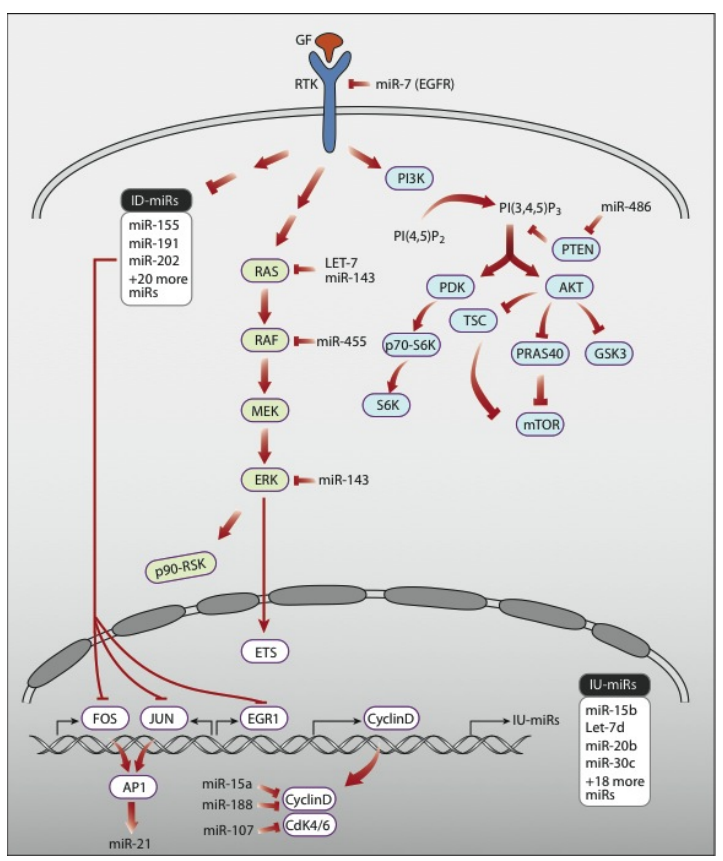
Figure 1. Schematic representation of RTK signaling pathways and representative regulatory microRNAs. Several biochemical signaling pathways are simultaneously activated upon binding of a growth factor (GF) to a receptor tyrosine kinase (RTK). Shown are two major cascades of protein kinases: the RAS-ERK pathway, which culminates in translocation of active ERK molecules to the nucleus, and the PI3K-to-AKT pathway, which requires phosphorylation of the inositol ring of phosphatitylinositol 4,5 bisphosphate at carbon position number 5. Both pathways regulate transcription factors, such as AP1, which comprises dimers of JUN and FOS. Note that many components of the signaling pathways are modulated at the mRNA level by microRNAs. Likewise, several microRNAs are induced or inhibited by RTK signals. They include a large group of microRNA molecules that undergo immediate down-regulation upon activation of EGFR (termed: ID-miRs) and several groups of microRNAs that are up-regulated immediately following RTK